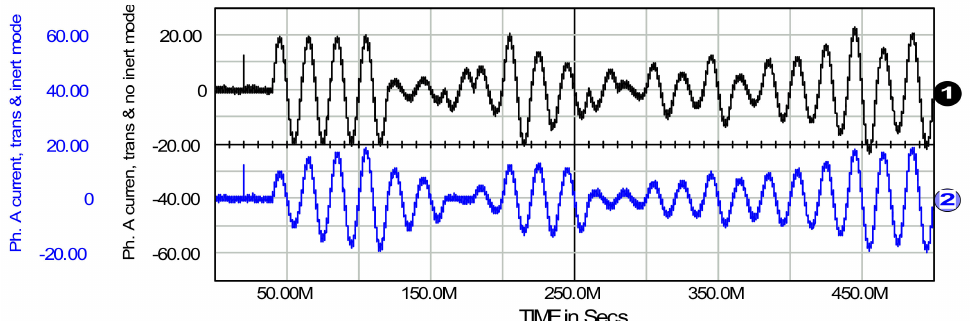
Figure 20. AC side source phase A current for transmit mode without inertia: waveforms 1, and for transmit mode in combination with inertia: waveform 2. Y scale for currents is 10A/div. Figure 19: DC-link capacitor voltage waveforms for store mode and then for the